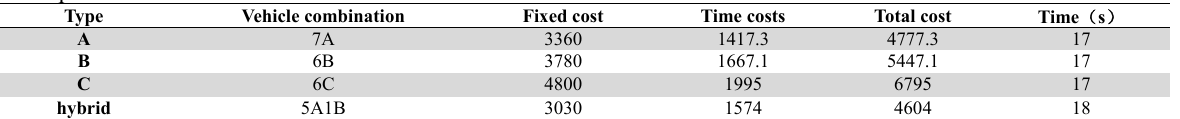
The experimental results